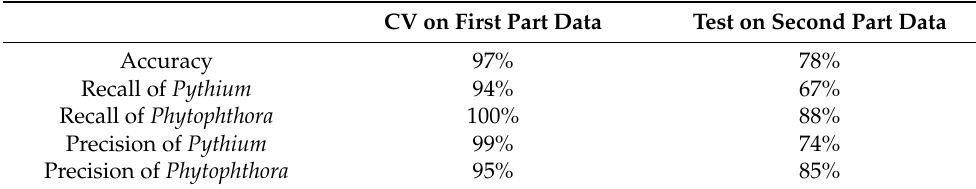
Table 3. Results of binary target classification. Two methods calculate various machine learning models’ performance measures: cross-validation performed on the data collected in the first part of the experiment and tested on a separate dataset of observations collected in the second part of the experiment.